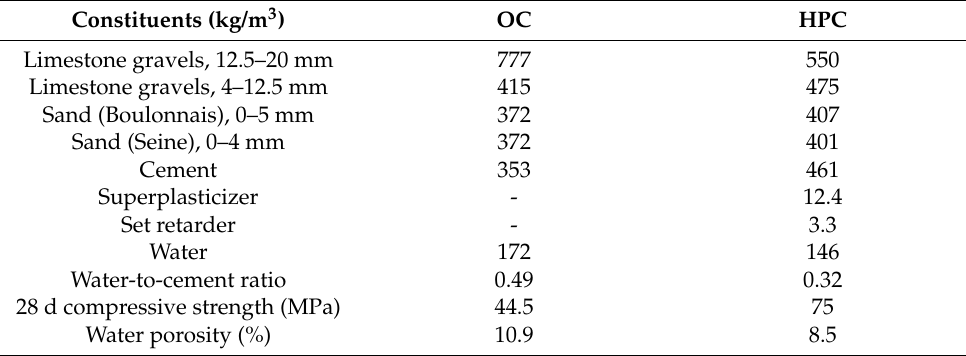
Table 1. The composition and characteristics of the concrete sources of OC and HPC. Constituents (kg/m 3 )